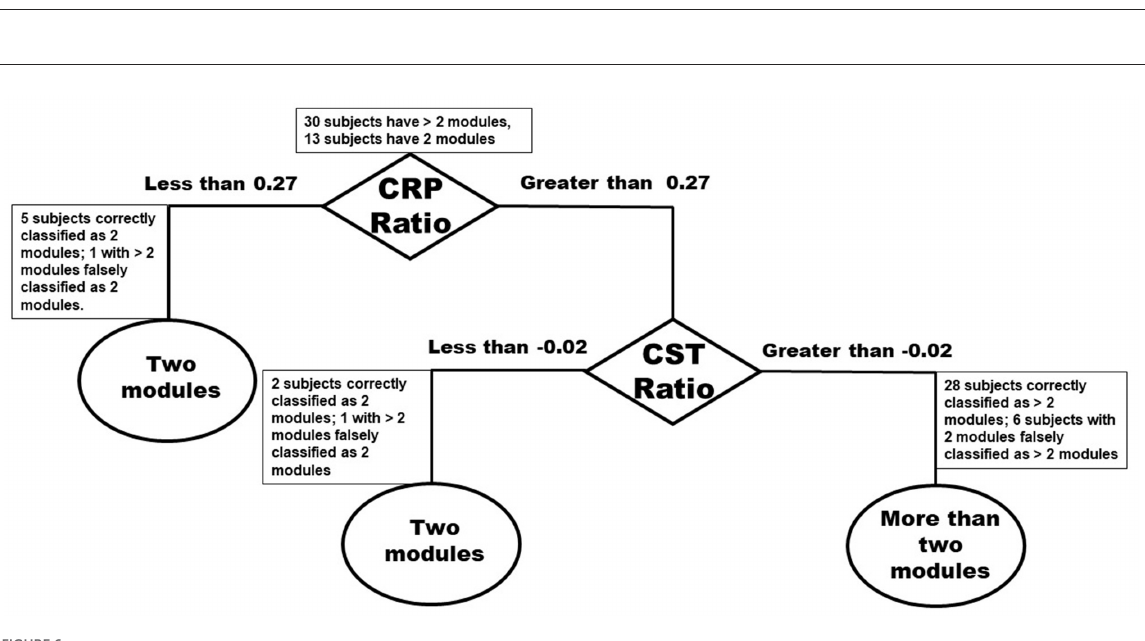
contralesional CRP streamlines in GroupC Correct2Modules individuals is indicative of possible increased compensatory connectivity of contralesional CRP in response to fewer